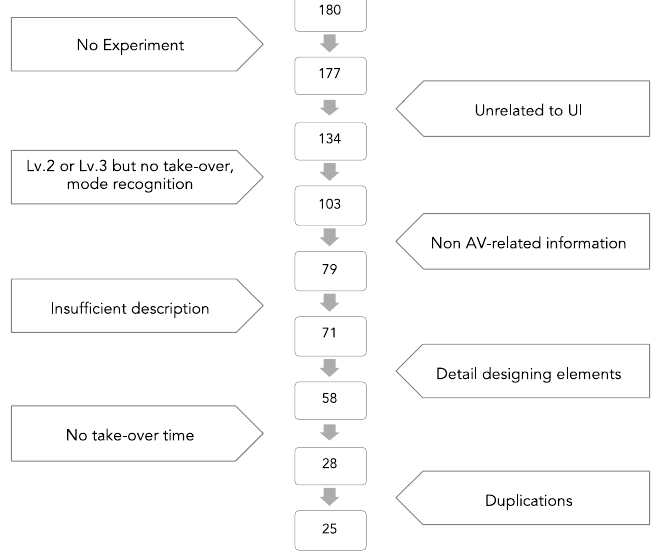
Figure 2 . Full text selection process resulting in twenty-five papers. Figure 2. Full text selection process resulting in twenty-five